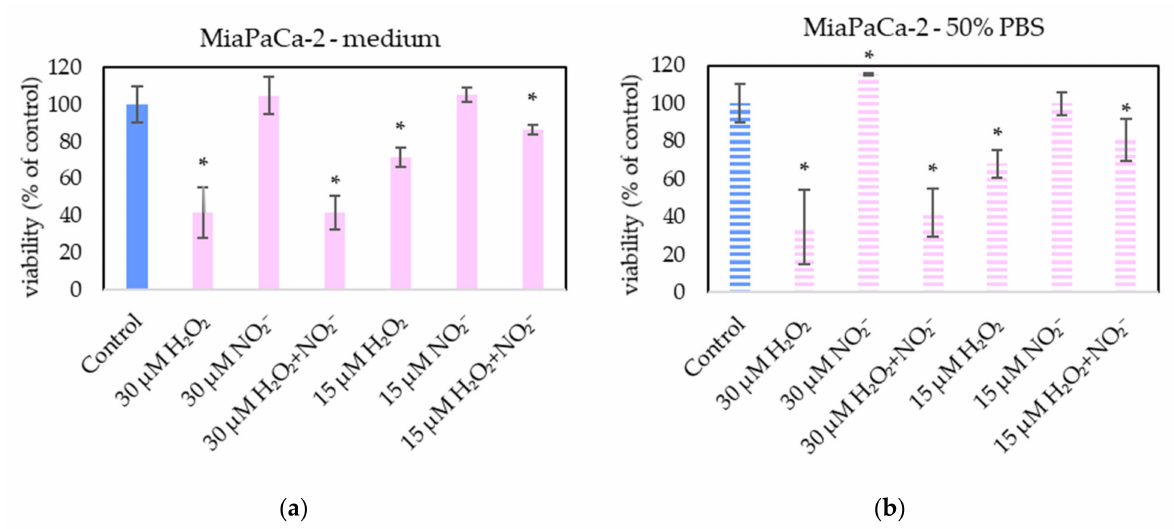
Figure 14. The effect of H 2 O 2 and NO 2 − on MiaPaCa-2 cells viability after 24 h incubation. H 2 O 2 and NO 2 − were externally added into 100% medium ( a ) or 50% PBS diluted with medium ( b ). Significance of was tested compared to cells in 100% medium or 50% PBS, no significant difference between only H 2 O 2 and H 2 O 2 + NO 2 − was found. Viability was normalized to the control cells incubated in the medium. The significant results ( p < 0.05) are marked with